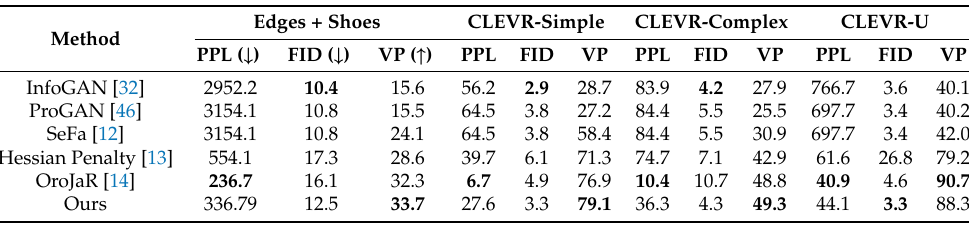
Table 4. Comparison of different methods on Edge + Shoes and CLEVR.